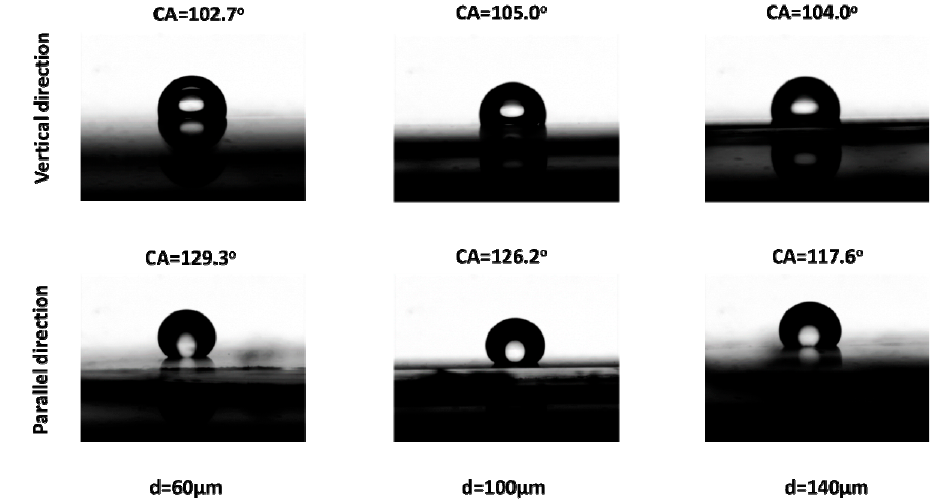
Figure 8. Wetting behavior of droplet on the microstructured surface with raised line in parallel direction and vertical direction with 60, 100, and 140 μ m line spacing.